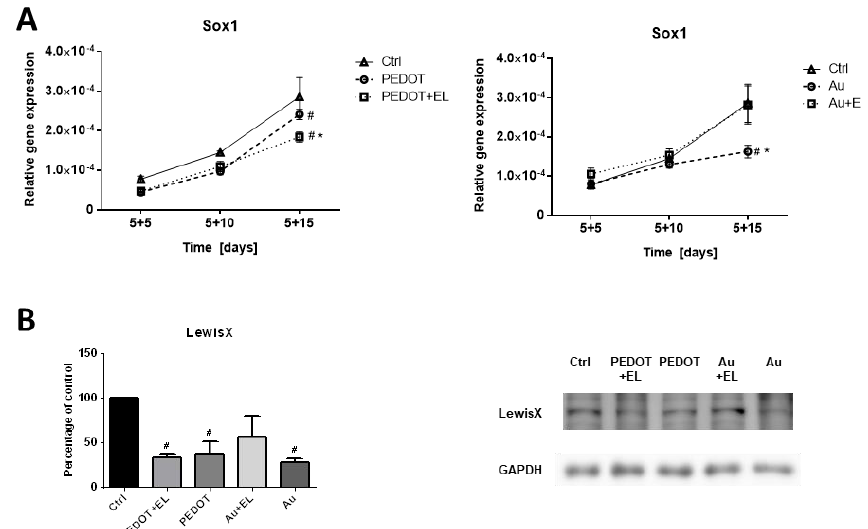
Figure 5. The effect of electrostimulation on expression of neural transcriptional factor Sox1 and LewisX antigen on PEDOT:PSS-based platform and platform with gold. These are markers of neural differentiation. The mRNA levels of transcription factor SOX-1 ( A ) were analyzed in mESCs line R1 which were differentiated for 20 days. Different time points were studied (5 + 5, 5 + 10, 5 + 15 d). These time points represent individual phases of differentiation. Level of antigen LewisX ( B ) was